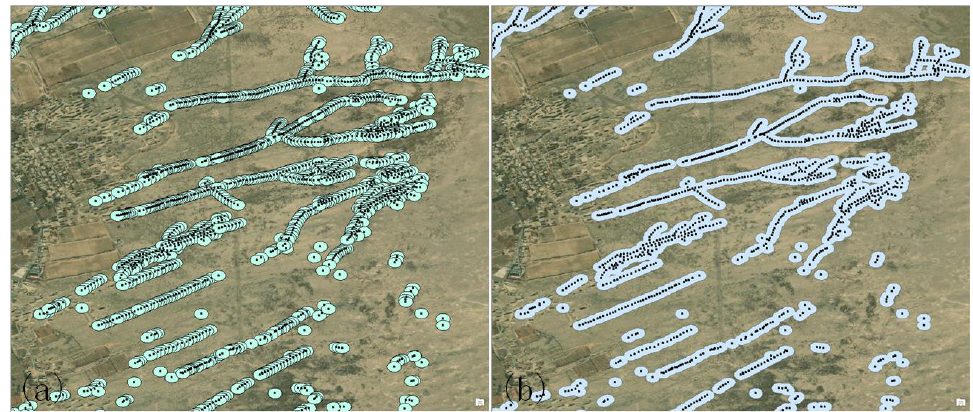
Figure 9. ( a ): Buffer diagram generated based on the average distance between karez shafts predicted by YOLOv5. The point is the shaft predicted by YOLOv5, and the circle represents the buffer range of each shaft. ( b ): The result of buffer map of shaft after dissolve operation.